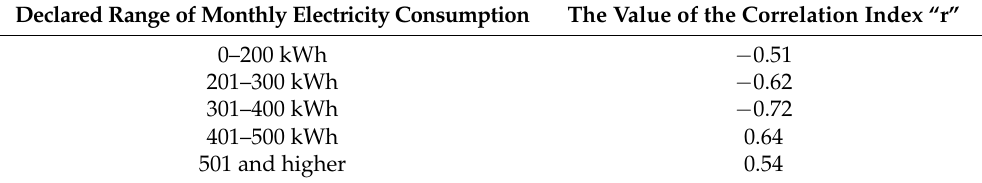
Table 2. Results on the correlation of electricity consumption data and the number of photovoltaic installations in selected households in the Szemud Municipality in